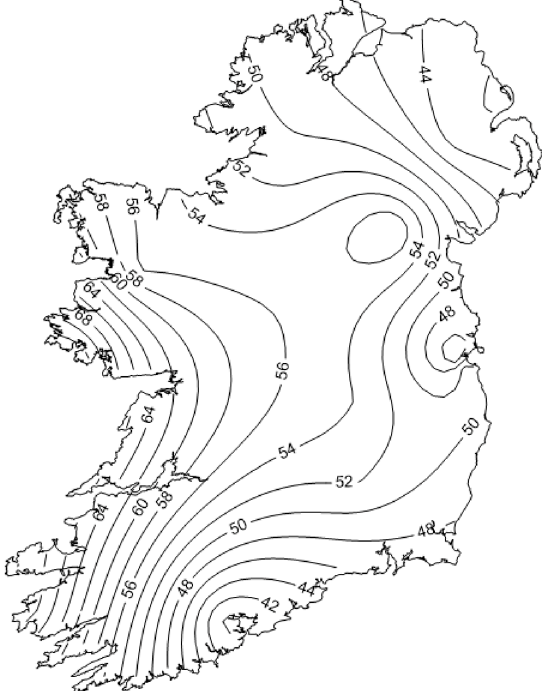
Figure 3. The mean ozone concentration ( µ g/m 3 ) during the period 2015–2019 mapped from 11 sta- tions using kriging interpolation. The highest concentrations were recorded at stations along the west coast, with the lowest concentrations in urban centres (see Figure 1 for station locations).